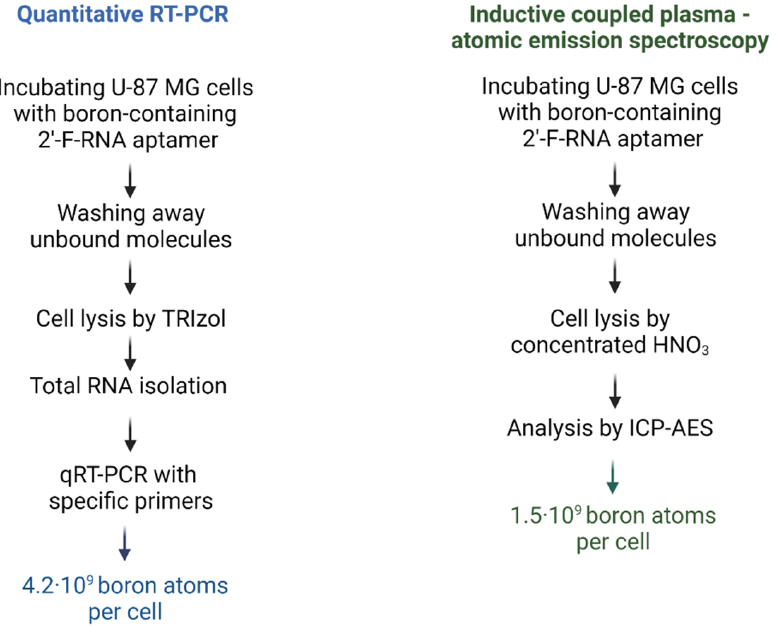
Figure 5. Scheme and results of the qRT ‐ PCR assay and ICP ‐ AES measuring for the internalization of boron ‐ containing aptamer GL44 ‐ 5B12 into U ‐ 87 MG glioblastoma